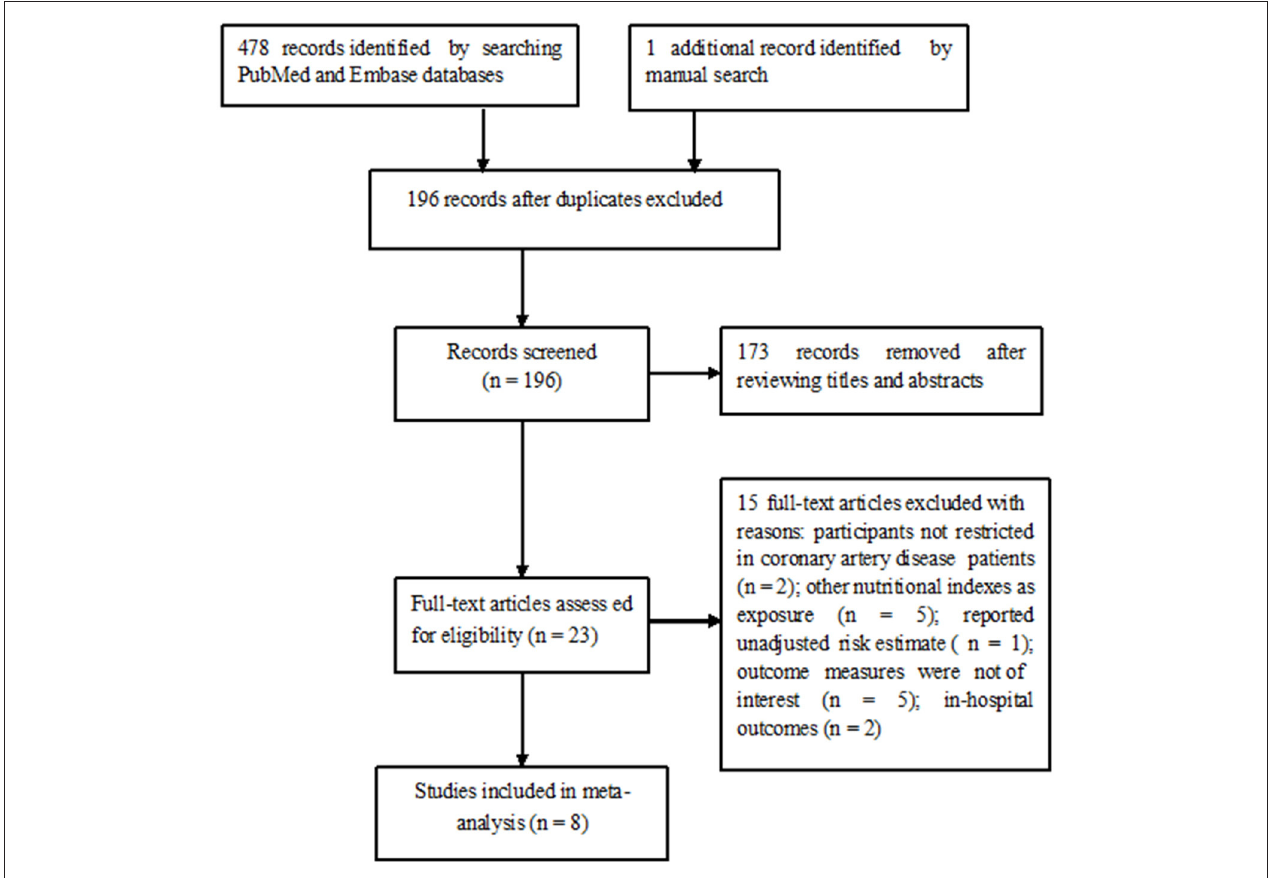
FIGURE 1 | Flowchart showing the study selection